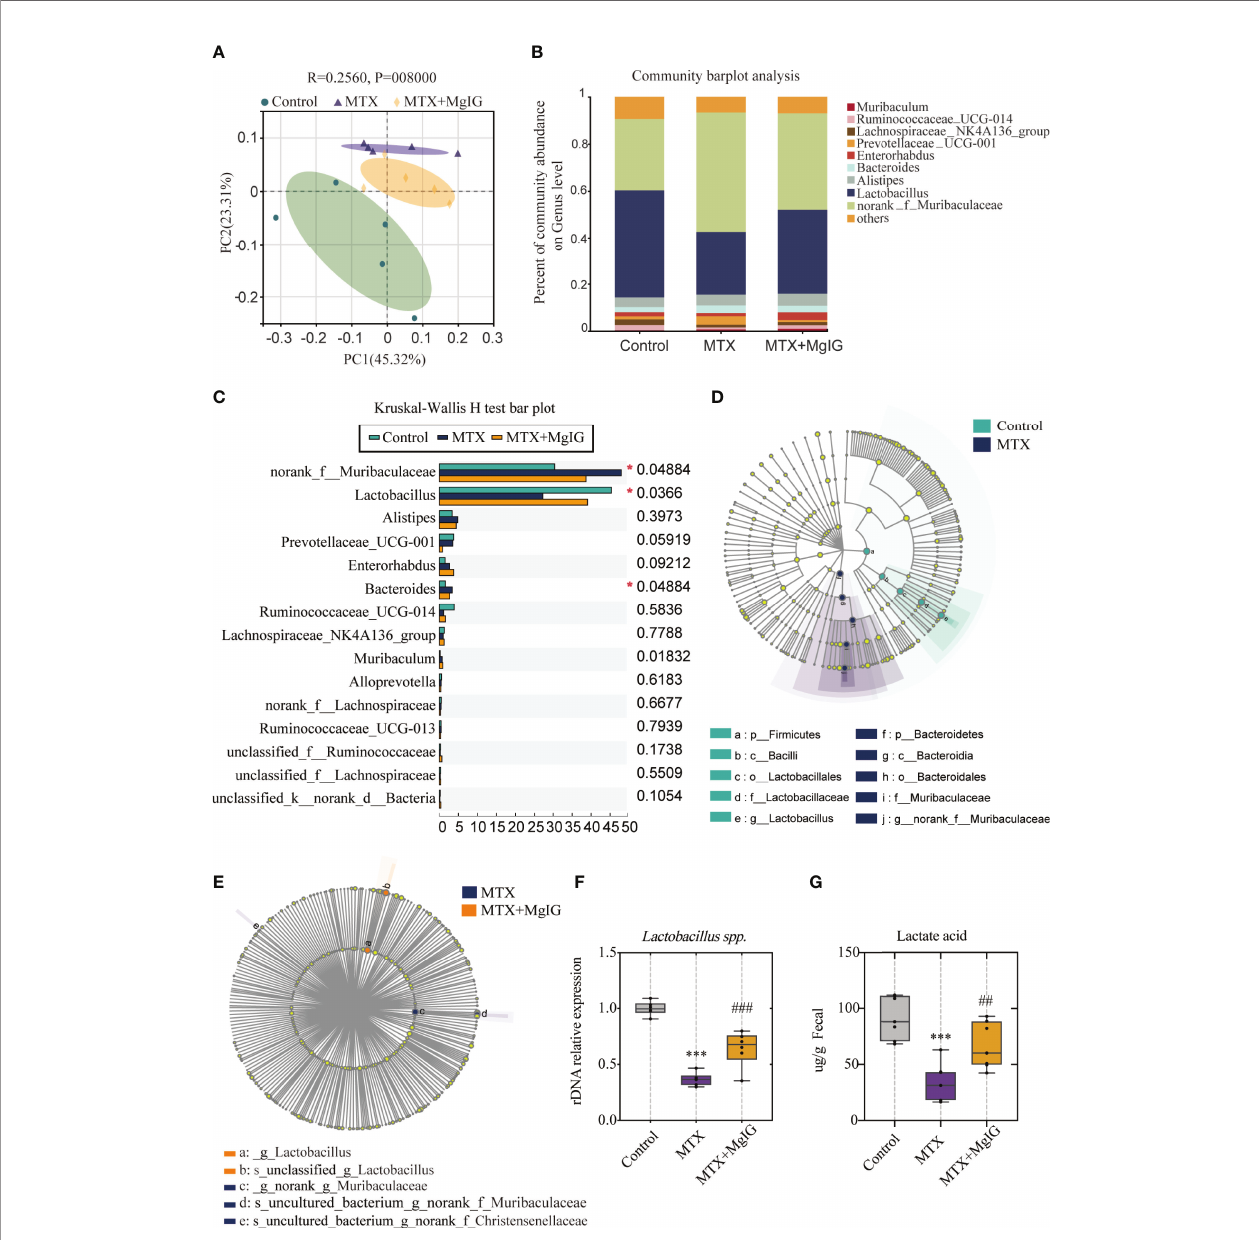
FIGURE 6 | 16s rDNA sequencing revealed altered microbiota composition after MTX or MgIG treatment (A) PCoA analysis with the ANOSIM signi fi cant test for each group (n = 5). (B) Relative abundance of microbial taxa was determined at the genus level. Top 10 abundances are shown. (C) Signi fi cance test of multiple groups using Kruskal-Wallis H test. (D, E) Multilevel species-level bar chart from LEfSe analysis, showing biomarker taxa at the genus level (LDA score) of >4 and a signi fi cance of P < 0.05 determined by the Wilcoxon signed-rank test. (F) 16s rDNA relative expression measured by quantitative PCR. (G) Fecal lactic acid concentration of each group (n = 6). ***p < 0.001, compared with Control group. ## p < 0.01, ### p < 0.001, compared with MTX